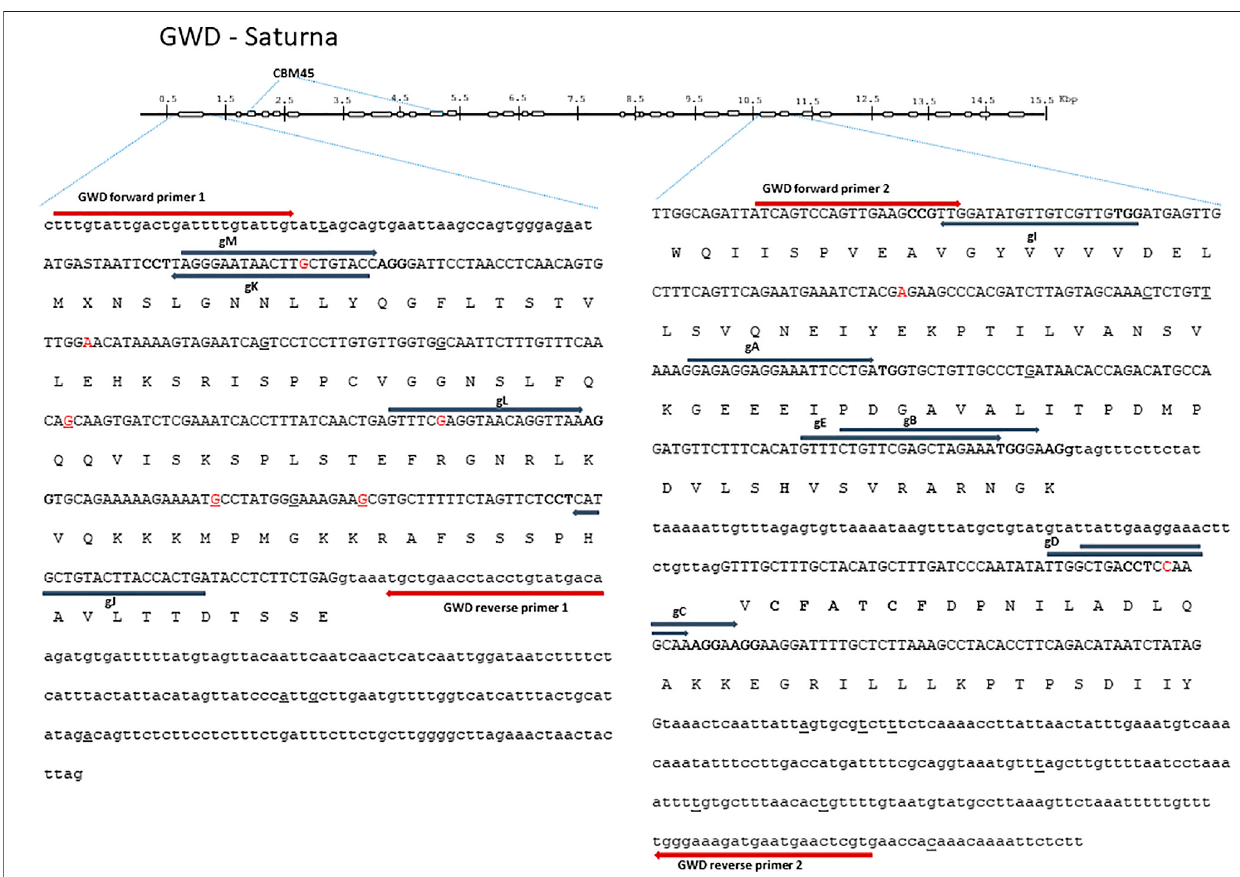
FIGURE 1 | Glucan Water Dikinase (GWD) 1 — structure and full allelic sequence of gRNA target regions. Overall gene structure with exons (boxes) and the area containingcarbohydrate bindingmodule(CBM)depicted above.Left:thenucleotidesequenceofexon1andintrons.Right:exon24and 25including introns.Exonsare depictedincapitalletterswiththeaminoacidsequenceindicated.Smallnucleotidepolymorphisms(SNPs)fromcultivarsincludedintheSPUDdatabasearemarkedwith red, and SNPs found in Saturna are underlined. Grey arrows designate gRNAs (gA, gB, gC, gD, gE, gI, gJ, gK, gL, and gM) with PAM sites marked in bold. Red arrowsdesignatediagnosticIDAAPCRprimers.The “ CFATC ” region,containingcysteine ’ shypothesizedtobeinvolvedininterorintra-disul fi debondformationandthus in putative redox-state modulation of GWD activity is marked with bold. The active site histidine residue is also marked with bold.